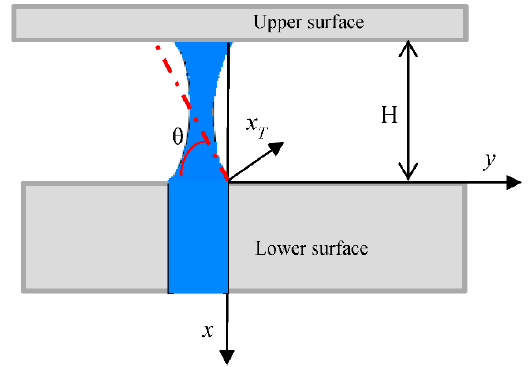
Figure 4. Schematic of liquid bridge profile parameters and coordinates.